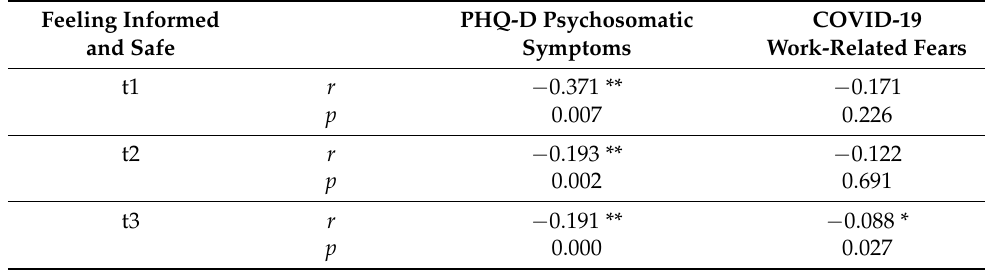
Table 5. Correlations between the psychosomatic score and the score “Feeling informed and